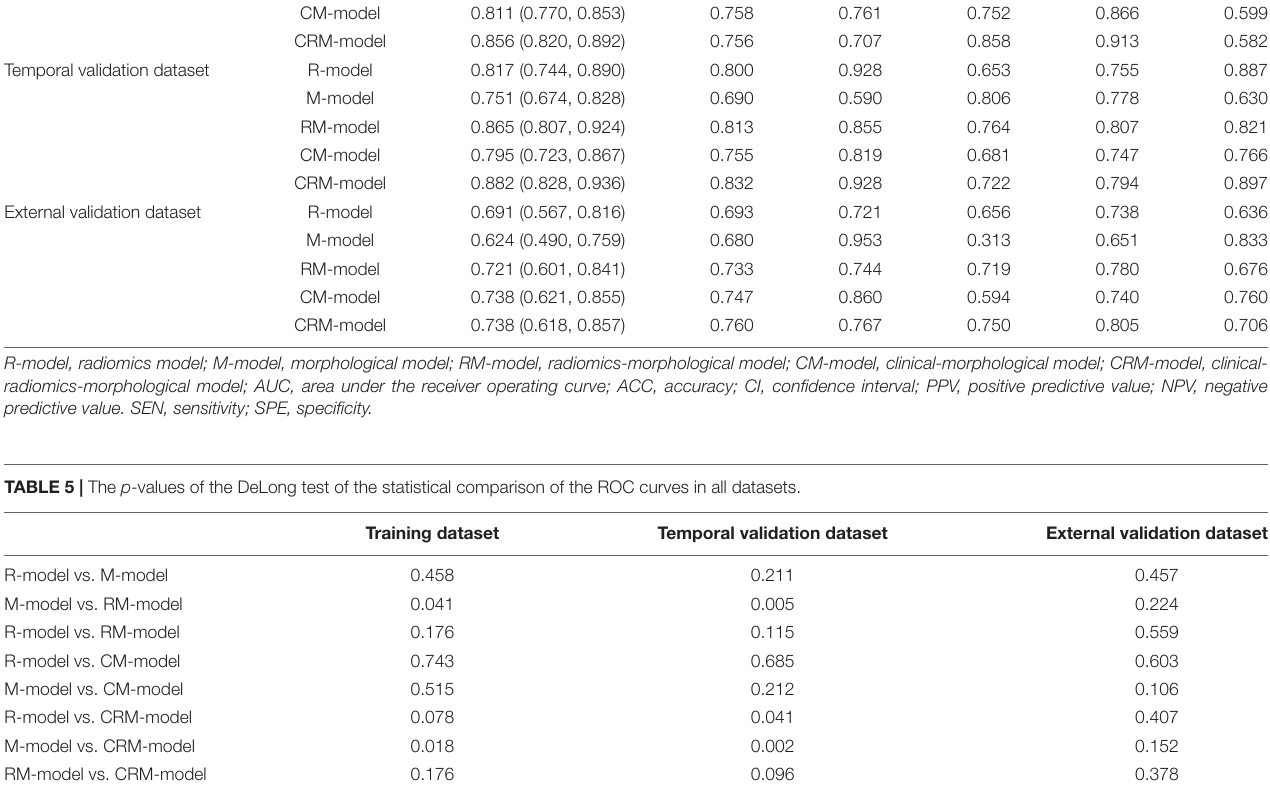
between those selected radiomics features and morphological predictors (VIF for all <